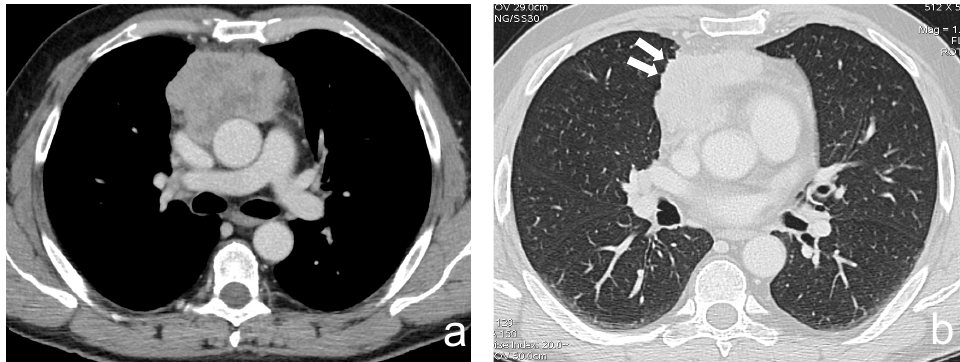
Figure 2. ( a , b ) A 63-year-old man with a poor differentiated squamous thymic carcinoma invading the pericardium and the lung (stage IIIa). Margins of the lesion are multilobulated and indented at the interface with the lung; the latter CT finding is better demonstrated using a lung window